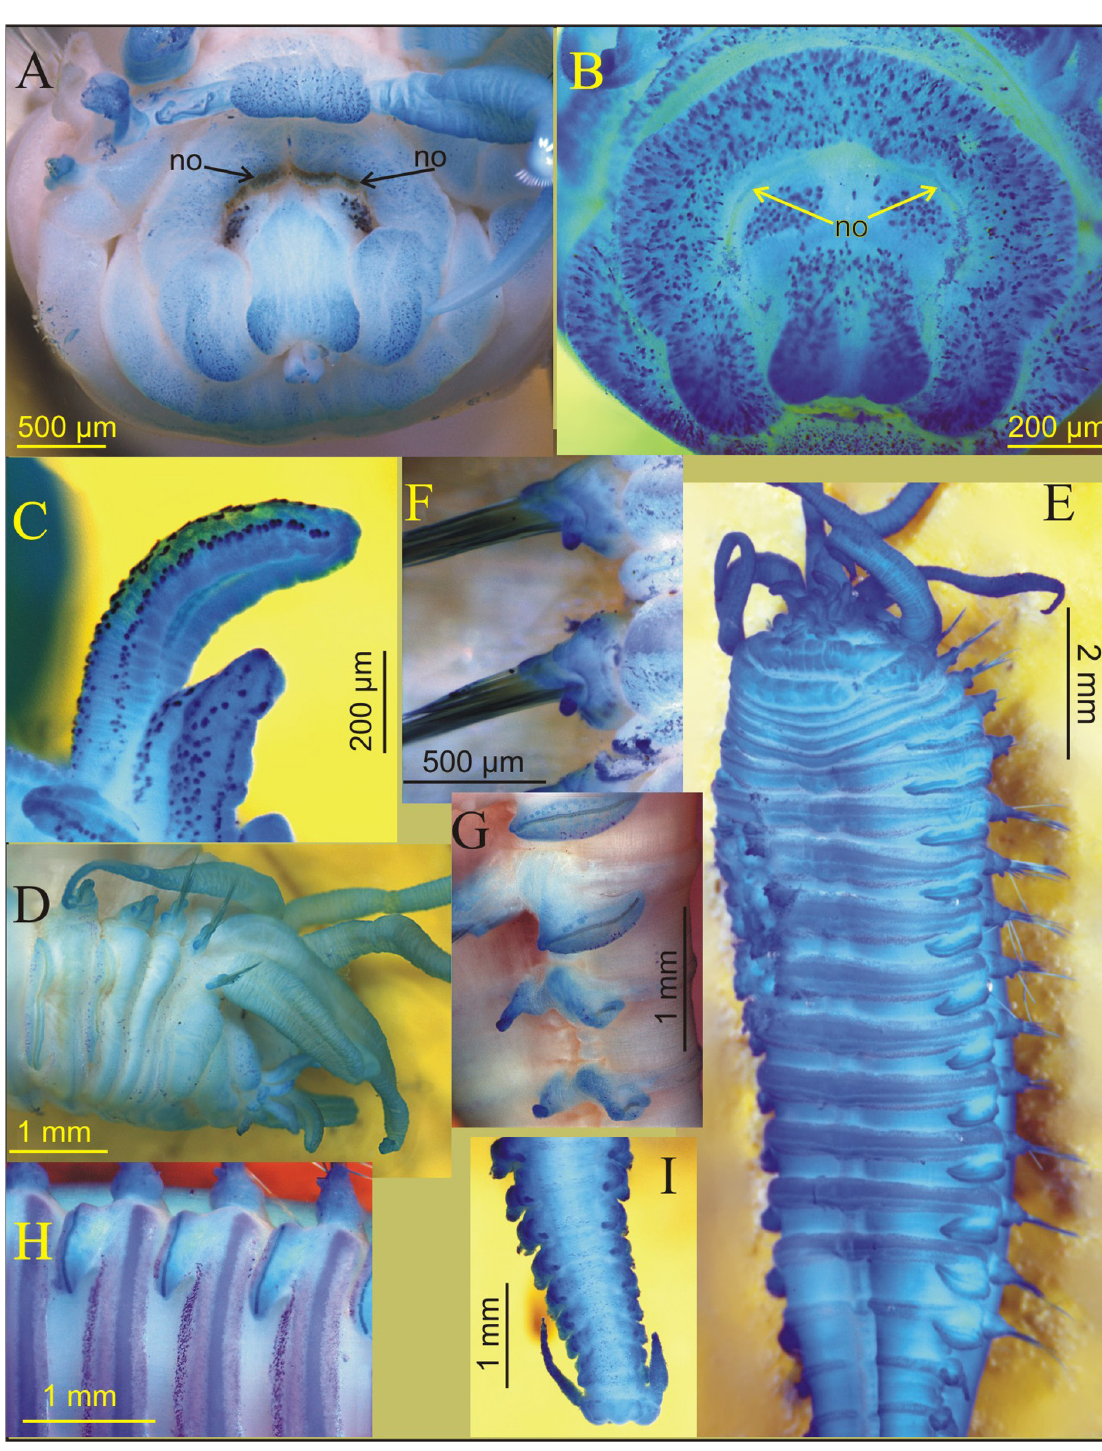
Fig. 1. A, C–I . Amage giacomobovei sp. nov., morphology. A . Paratype (MNA-07931). C–E, G–H . Paratype (MNA-06377). F, I . Paratype (MNA-07931). B . Amage auricula Malmgren, 1866, SP- 22 74, 74.633º, -164.500º, 465 m; arrows indicate the well-developed NO. A–B . Antero-dorsal view of prostomium. C . Buccal tentacles. D . Lateral view. E . Ventral view. F . Dorsal view of middle notopodia. G . Ventral view of last thoracic and first abdominal parapodia. H . Ventral view of middle thorax, showing details of staining pattern. I . Dorsal view of posterior end. Abbreviations: see Material and